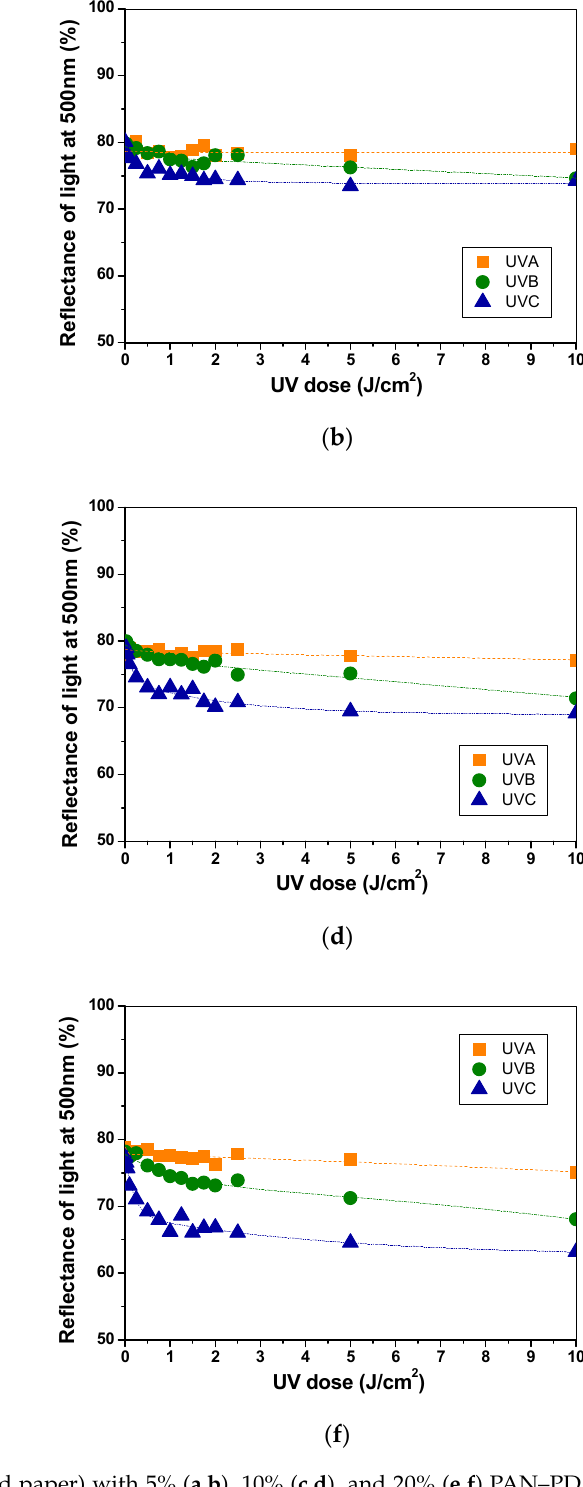
Figure 3. Basic characteristics of paper samples (non-refined paper) with 5% ( a , b ), 10% ( c , d ), and 20% ( e , f ) PAN–PDA dopant irradiated with UV light. Left column ( a , c , e ): reflectance spectra measured immediately after UV irradiation (UV doses are given in the graph). Right column ( b , d , f ): reflectance (at 500 nm) dependencies on the absorbed dose of UVA, UVB, and UVC light. Table 1. CIE Lab parameters of paper doped with PAN–PDA fibres derived from reflectance measurements of samples irradiated with UV light (non-refined paper).